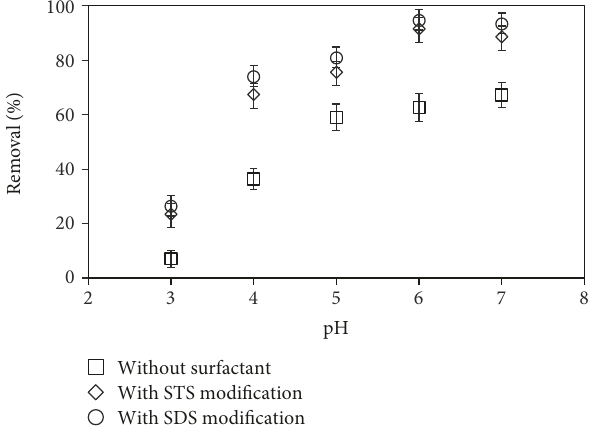
O (SMA) ( C (Cd 2+ ) =10ppm, pH 6, 2 3 i